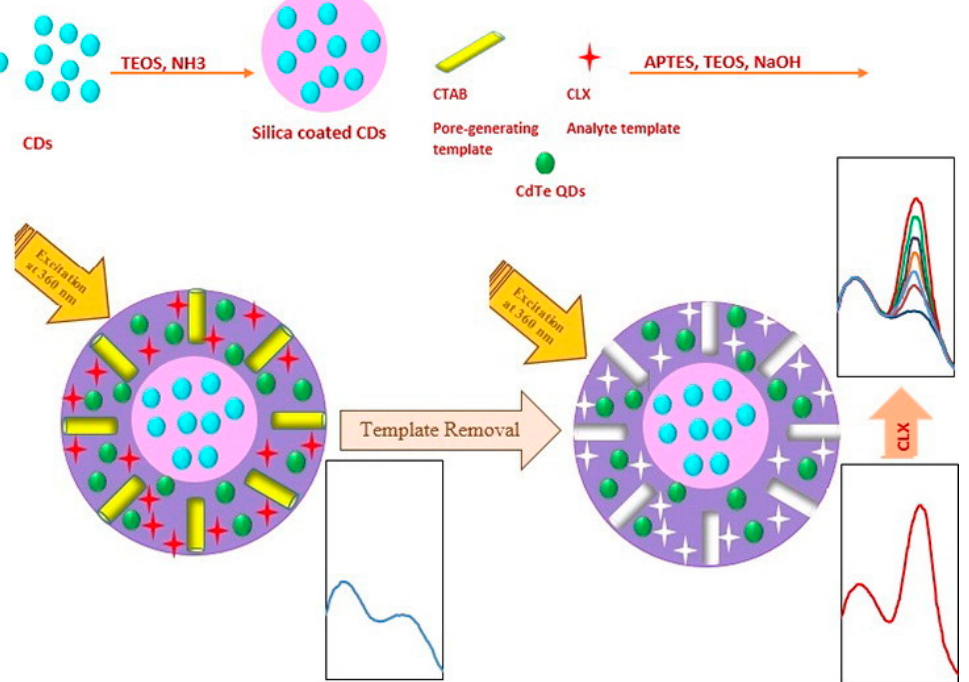
Figure 9. Schematic illustration of the mMIP@CDs/QDs hybrid sensor and the working principle for the detection of celecoxib. Reproduced from [132] with permission from Elsevier. Table 7. Optical sensors based on core-shell MIPs with a quantum dot core.